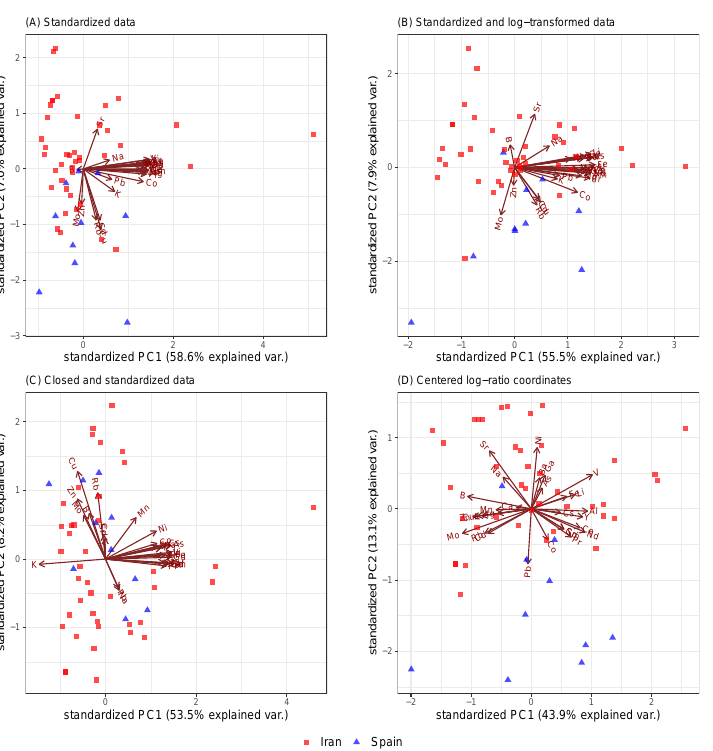
Figure 3. Biplots obtained from saffron samples originating from Iran and Spain. First two prin- cipal components represented by biplots of the PCA that was applied on ( A ) standardized data, ( B ) standardized and log-transformated data, ( C ) closed and standardized data, and ( D ) centred log-ratio coordinates.